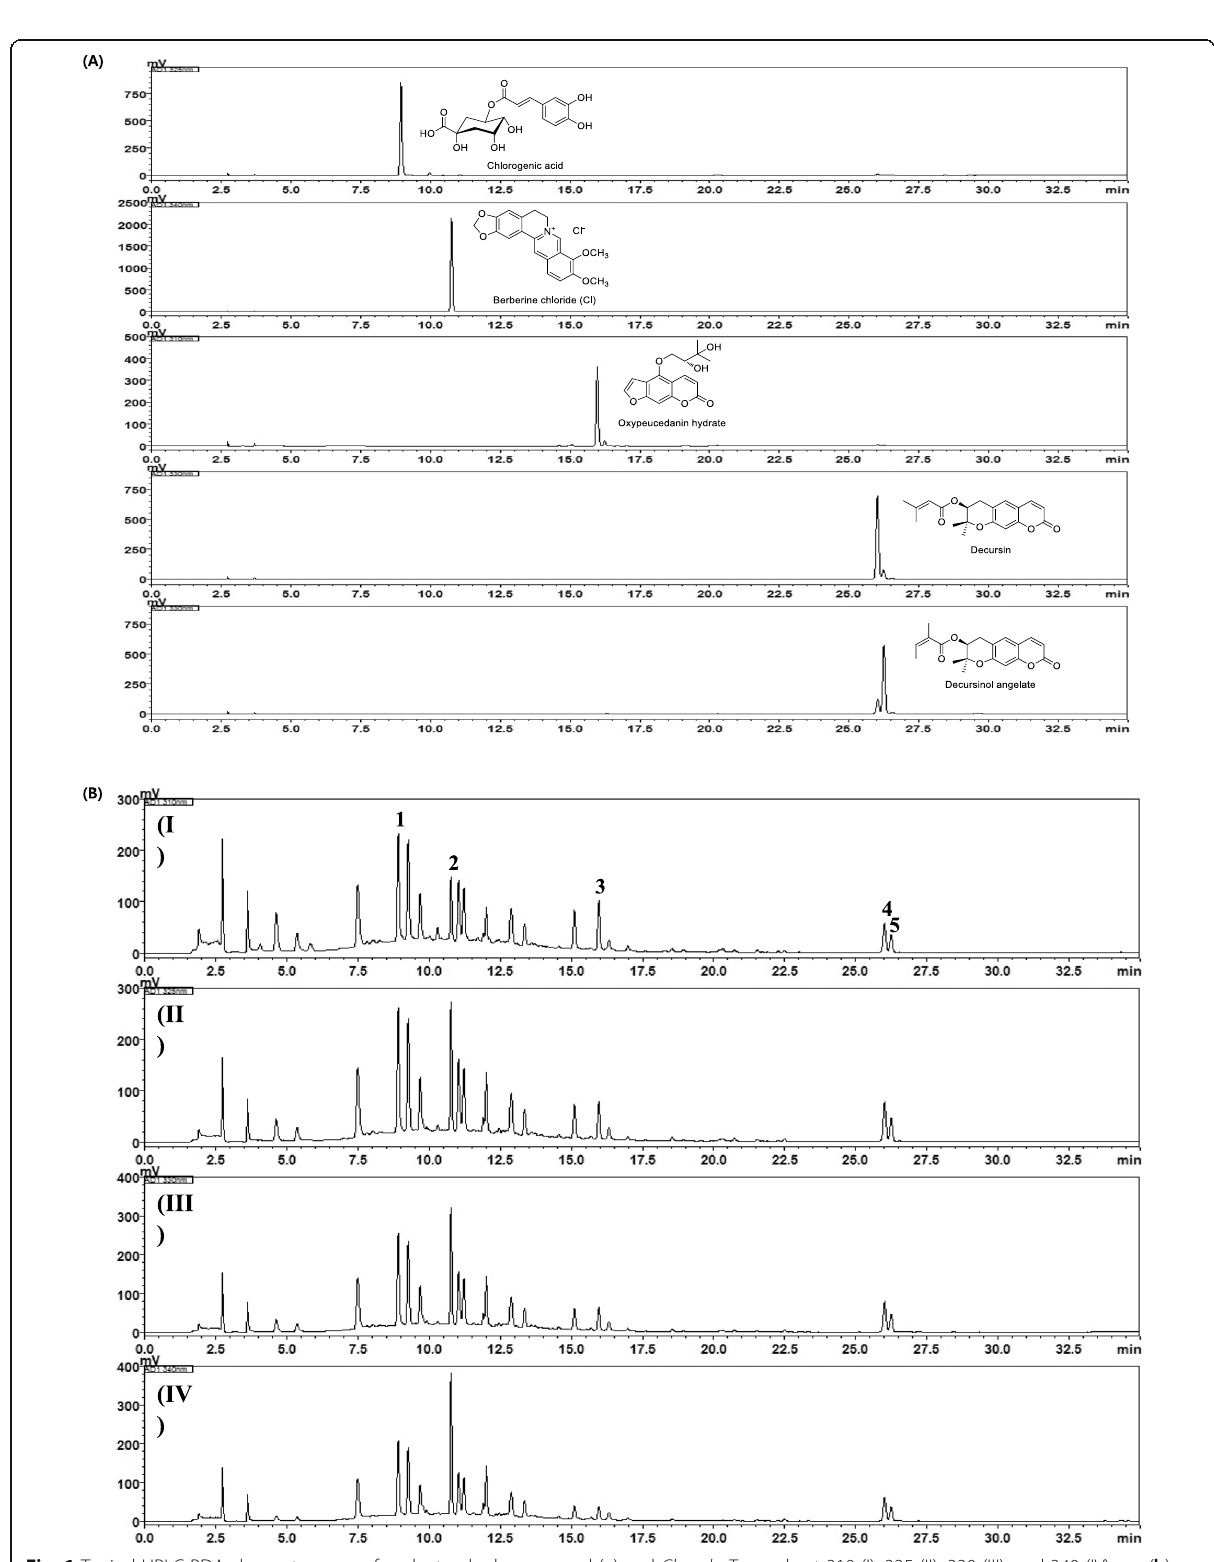
Fig. 1 Typical HPLC-PDA chromatograms of each standard compound ( a ) and ChondroT sample at 310 (I), 325 (II), 330 (III), and 340 (IV) nm ( b ). Chlorogenic acid (1), Berberine Cl (2), oxypeucedanin hydrate (3), decursin (4), and decursinol angelate